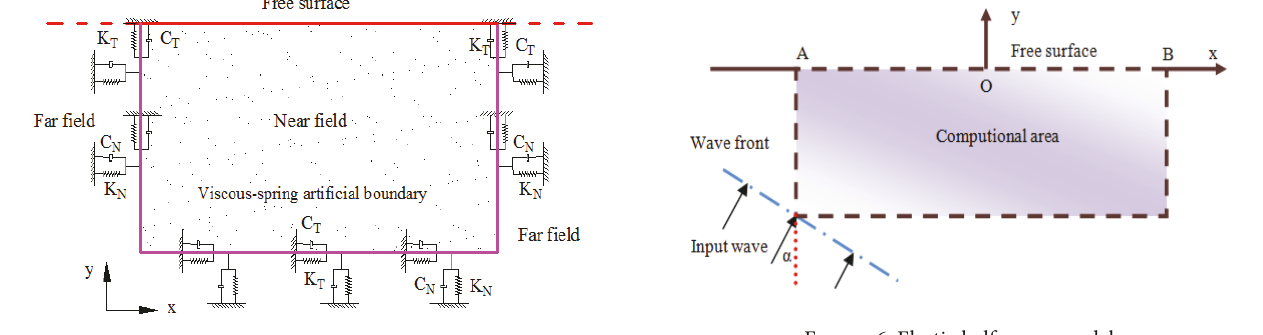
Figure 5: The viscous-spring boundary model.